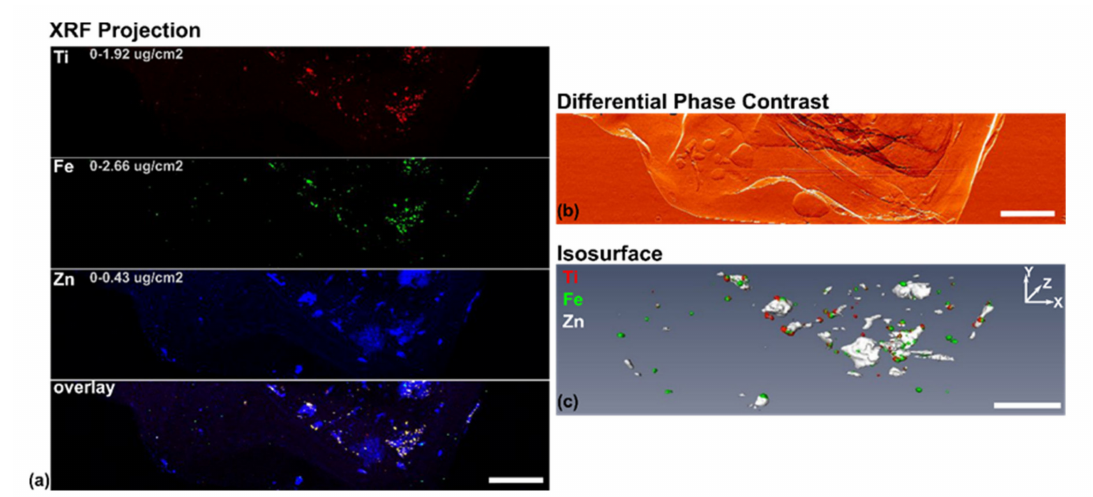
Figure 6. XRF projection and reconstructed volume of the sample. ( a ) 2D XRF projection of the sample, showing the distributions of Ti, Fe, Zn, and their overlay from the cells; ( b ) 2D differential phase contrast image of the sample, with the structures mainly formed by paraffin and Ultralene thin film; ( c ) Isosurface of reconstructed 3D volume (see rotation movie Video S1: outerTomo) showing the distributions of both the cell, represented by Zn (white) and the nanocomposites, represented by Ti (red) and Fe (green). The scale bar in each case is 200 µ m.